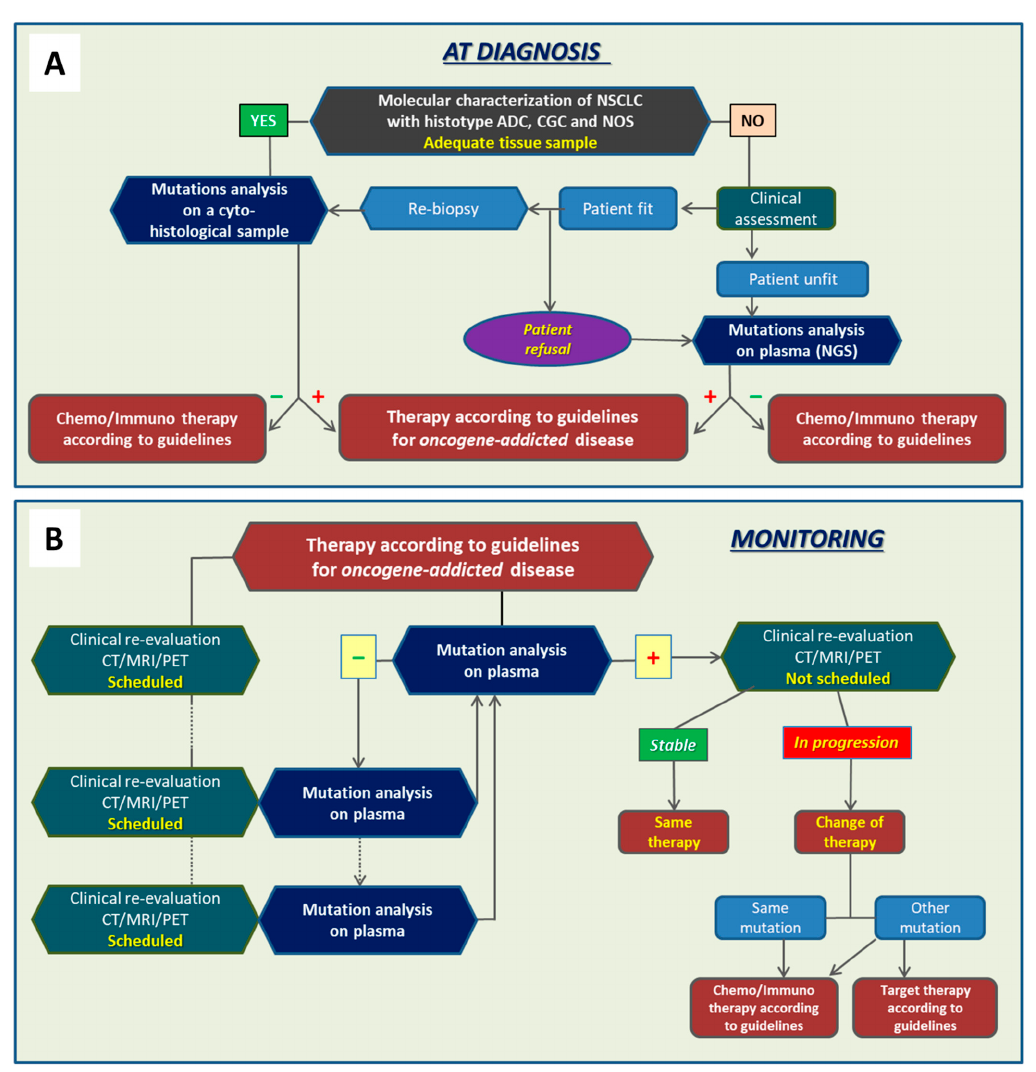
Figure 3. Clinical algorithms for the use of liquid biopsy at diagnosis ( A ) and during follow-up ( B ).